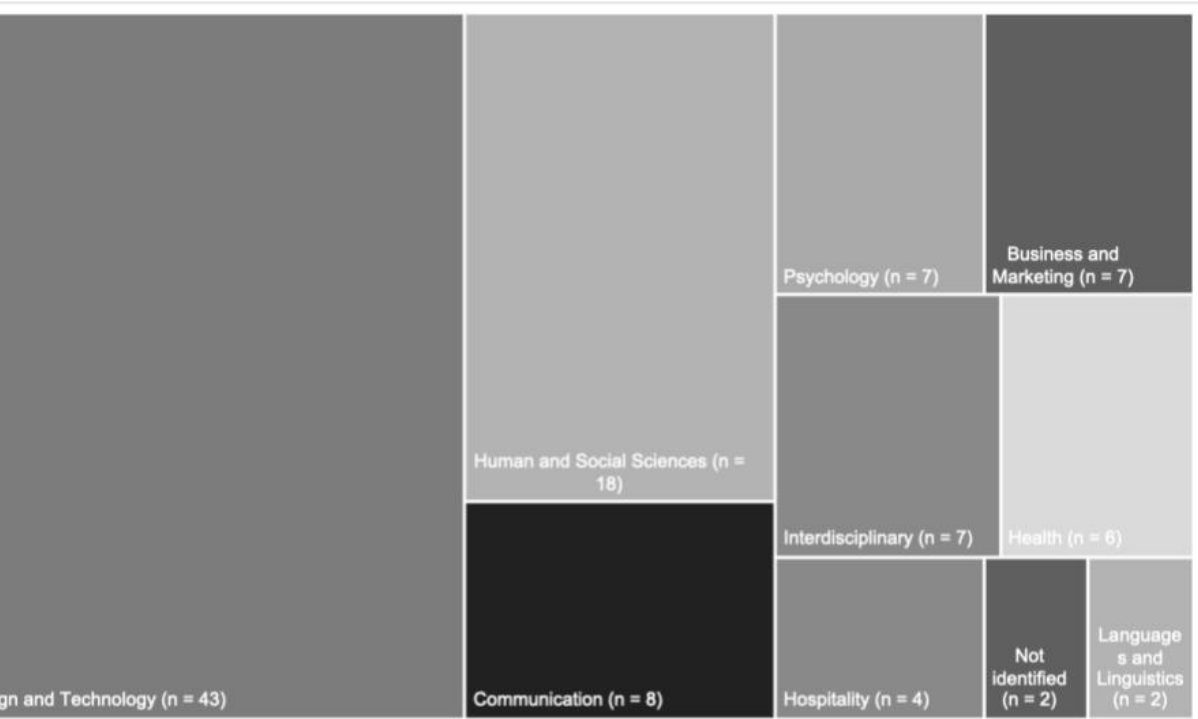
Figure 4. Distribution of the analyzed publications by area of knowledge.